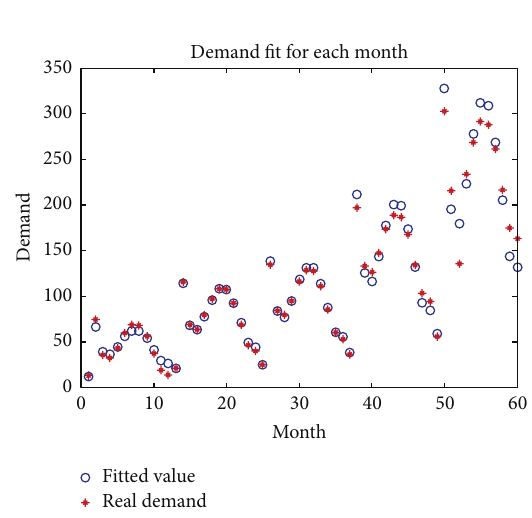
Figure 2: Comparison between real and estimated demand.